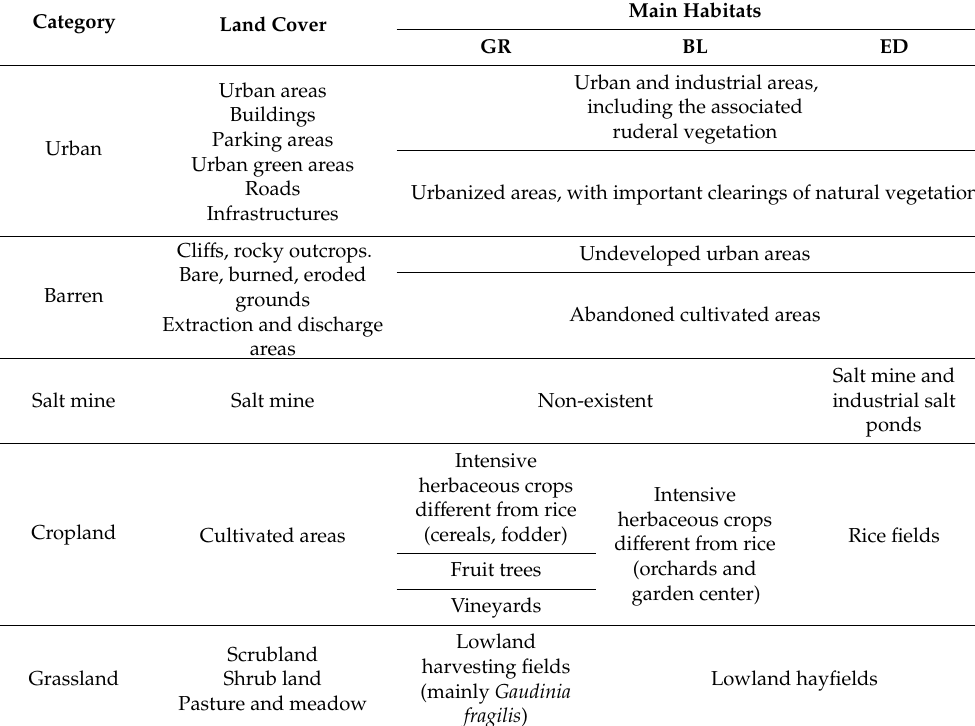
Table A1. Land cover types and main habitats found in the study